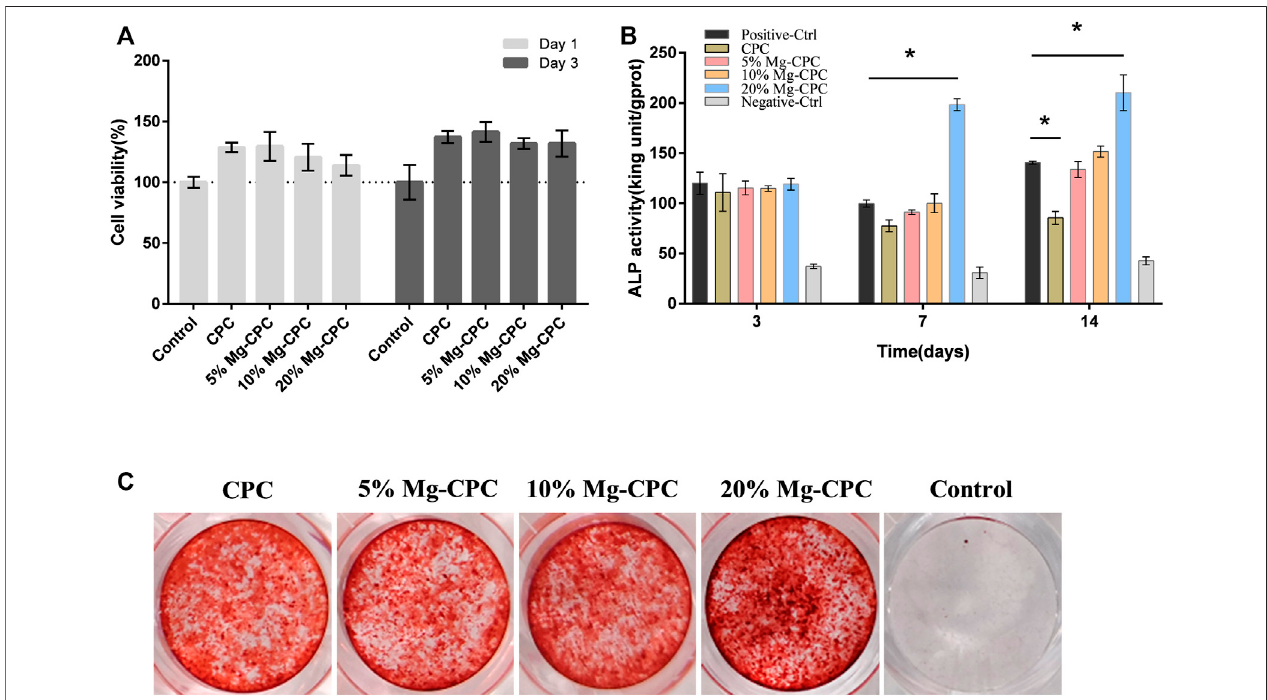
FIGURE 4 | Effect of cement on hBMMSCs. (A) Cell viability assay of CPC and Mg-CPCs. (B) ALP activity assay of CPC and Mg-CPC. (C) Alizarin red staining of CPC and Mg-CPCs (* p <